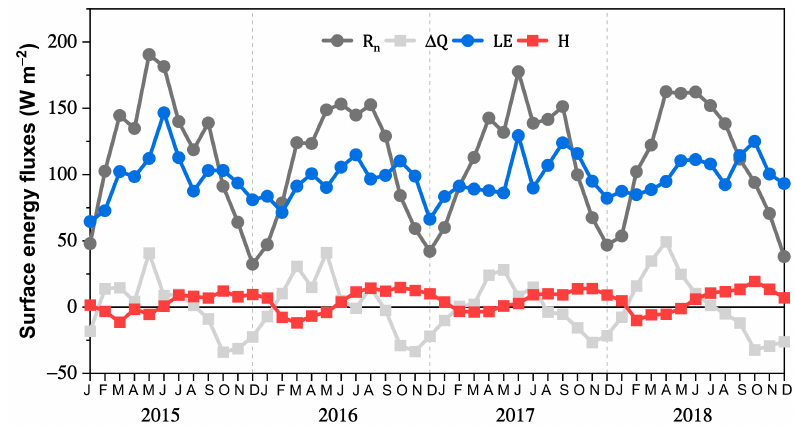
Figure3. Monthlyaveragecomponentsofthesurfaceenergybudgetduring2015–2018. R n